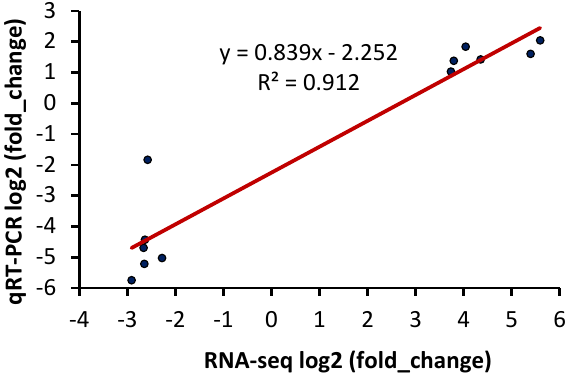
Figure 6. Line fit plot of qRT-PCR log2 (fold change) data and mRNA sequence log2 (fold change) data of selected differentially expressed genes between resistant and susceptible goats showing trend line, R-squared value, and linear regression model.